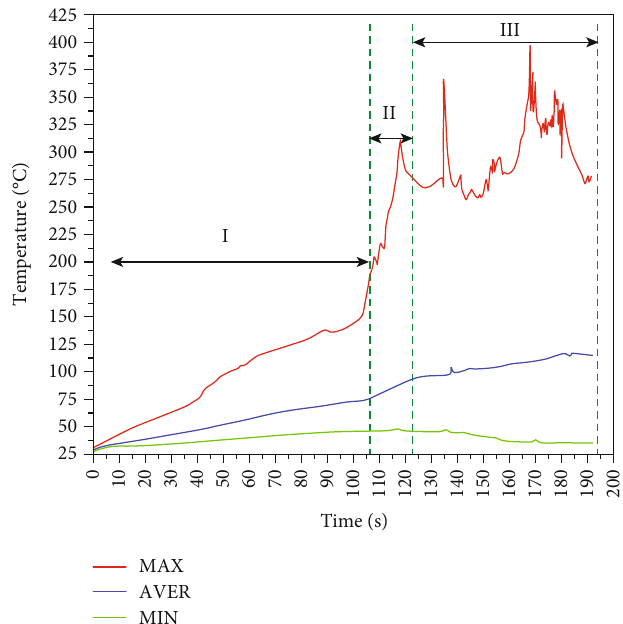
Figure 4: MAM temperature-time curves.